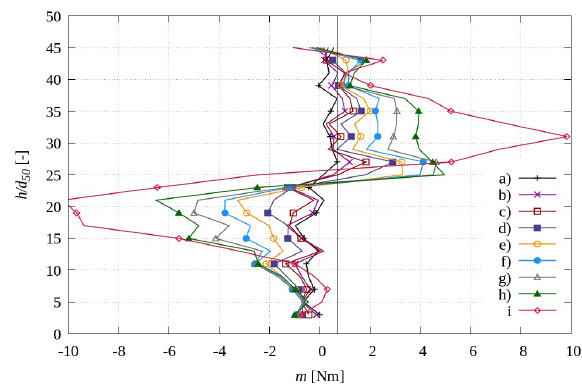
Figure 30: Distribution of the resultant moment m acting on spheres across the normalized specimen height h / d for: a) u = 0.25 mm, b) u x mm, e) u = 1.25 mm, f) u x mm and i) u = 10.00 mm ( e x (dark vertical line demonstrates 5% limit).